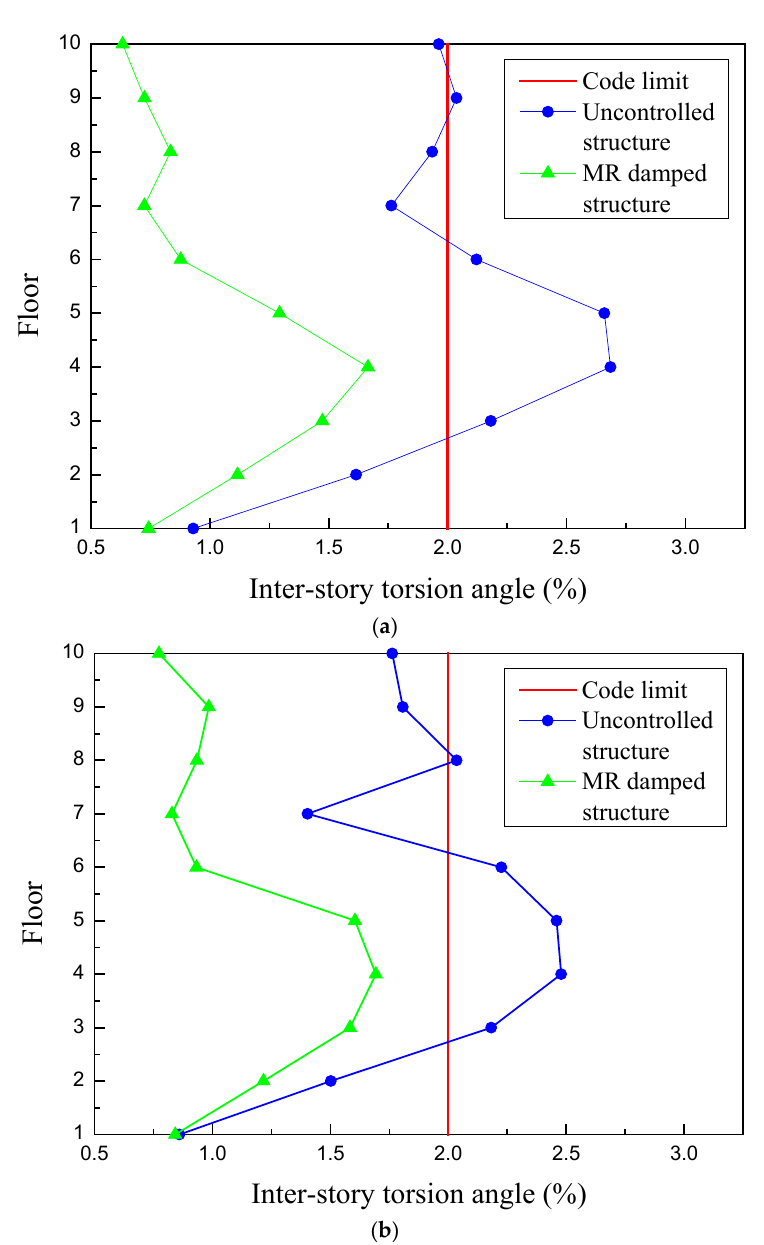
Figure 15. Inter-story torsion angles of the uncontrolled and MR damped structure. ( a ) El Centro. ( b ) Taft.